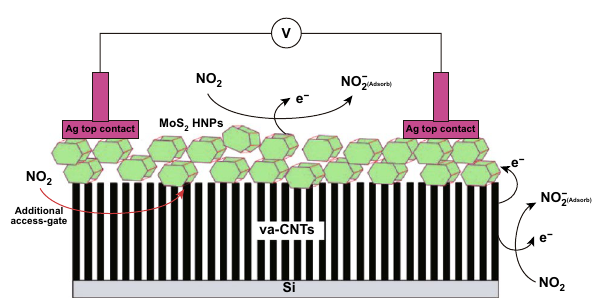
Fig. 20 Schematic of MoS 2 deposited over CNT-based device. Reproduced with permission from Ref. [342]. Copyright (2017) Wiley-VCH